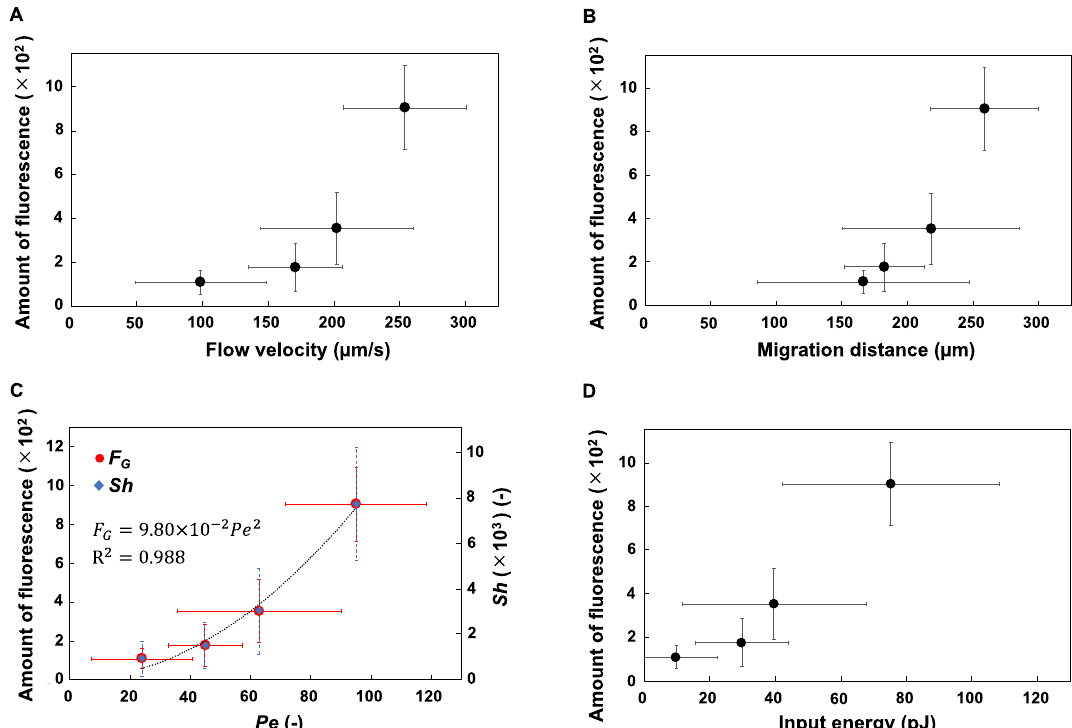
Figure 5. Associations of glucose fluorescence in intestinal cells after ingestion of 0.13% (v/v) OP50-1 labeled with fluorescent glucose for 60 min with intestinal flows during defecation. ( A ) Associations of glucose uptake in intestinal cells with mean particle retrograde and anterograde flow velocities. ( B ) Associations of glucose uptake in intestinal cells with mean particle retrograde and anterograde flow velocities. ( C ) Associations of glucose uptake or Sherwood number (Eq. [4]) with Péclet number (Eq. [1]). Fluorescence data were fitted to the function F G = 9.80 × 10 −2 Pe 2 with R 2 = 0.988. ( D ) Associations of glucose uptake at 60 min with input energy during the DMP (Eq. [8]). Error bars indicate standard